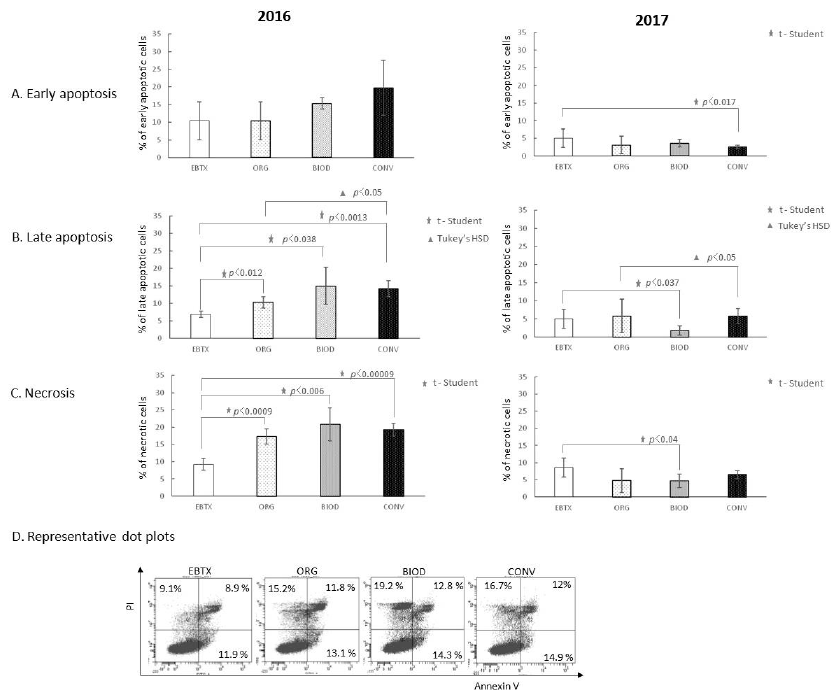
Figure 5. Interference of blueberry extracts on the apoptosis and necrosis-inducing activity of Erbitux. ( A ) Effect of blueberry extracts on the induction of apoptosis by Erbitux at the early phase. ( B ) Effect of blueberry extracts on the induction of apoptosis by Erbitux at the late phase. ( C ) Effect of blueberry extracts on the necrosis-inducing potential of Erbitux. ( D ) Representative dot plots for AnnexinV/FITC and PI staining for 2016. EBTX—HT-29 cell culture with Erbitux alone; ORG, BIOD, CONV—HT-29 cell culture with blueberry extracts from particular types of production system